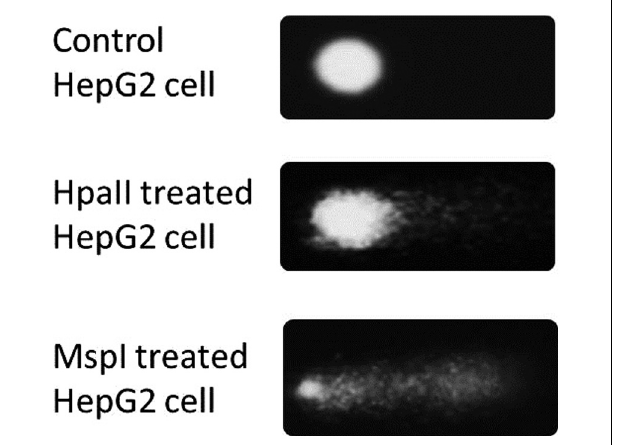
FIGURE 1 | Comets created by the treating nucleoids with the isoschizomeric enzymes MspI and HpaII.